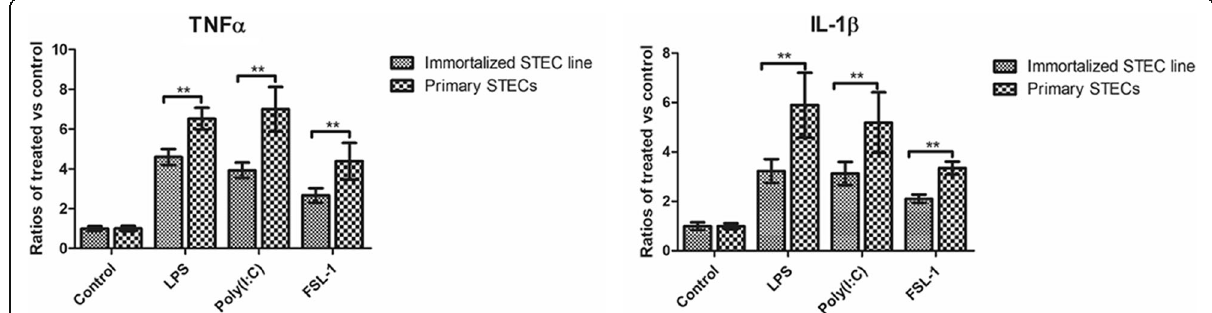
Fig. 6 Induction of pro-inflammatory cytokines in Ali-cultured immortalized STEC line and primary STECs in response to Toll-like receptor (TLR) agonist stimulation. Immortalized STEC line and primary STECs were cultured under Ali conditions. At D14, the cells were treated with TLR agonists for 24 h. The cellular supernatants were collected, and cytokine analysis was performed with TNF α and IL-1 β ELISA kits. Data are presented as the ratios of cytokine expression by treated cells relative to expression by control cells in immortalized or primary cells, and given as the mean +/ − SD of three experiments, each done in triplicate ( n =9). (* P <0.05, ** P